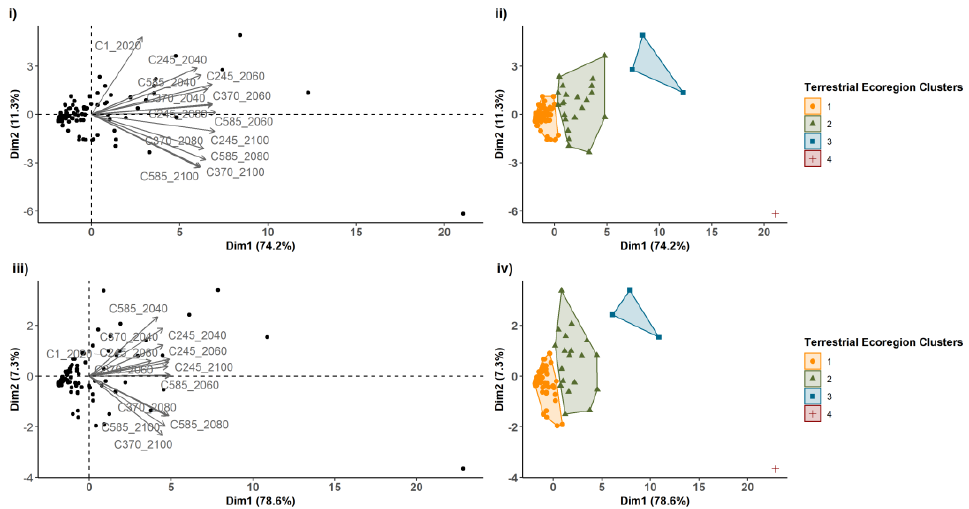
Figure 4. Connectivity terrestrial ecoregion ordination and cluster classification. Principal component analysis (( i ) for 60 – 100% distribution and ( iii ) for 80 – 100% distribution) and hierarchical classification (( ii ) for 60 – 100% distribution and ( iv ) for 80 – 100% distribution) focusing on link data numbers from the terrestrial ecoregions according to three shared socioeconomic pathways (optimistic — SSP245, middle of the road — SSP370, and worst — SSP585 in years 2040, 2060, 2080, and 2100. The symbols correspond to terrestrial ecoregions for points and thirteen climate change scenarios for grey arrows ( i ) for 60 – 100% distribution and ( iii ) for 80 – 100% distribution) and to terrestrial ecoregions grouped in four clusters (with different colors in the graph) with similar connectivity ( ii ) for 60 – 100% distribution and ( iv ) for 80 – 100% distribution). PCA1 and PCA2 explained 74.2% and 11.3% of the variance for 60 – 100% distribution ( i ), respectively, and PCA1 and PCA2 explained 78.6% and 7.3% of the variance for 80 – 100% distribution ( iv ), respectively.